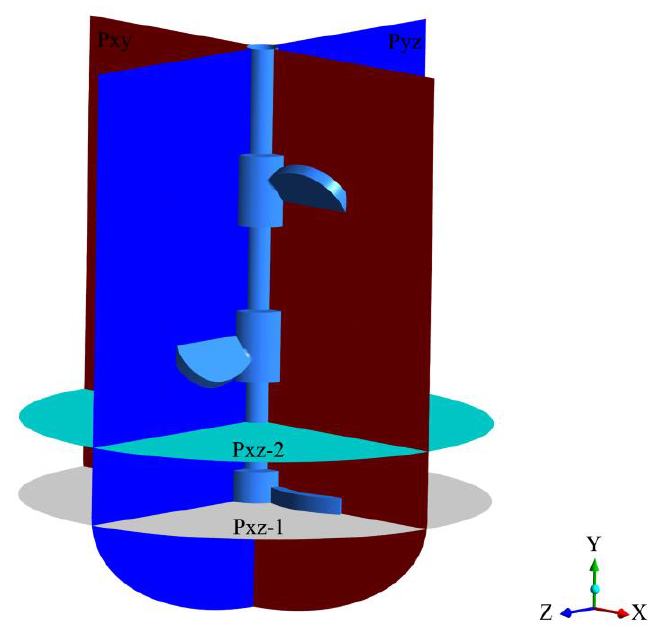
Figure 6. Sampling